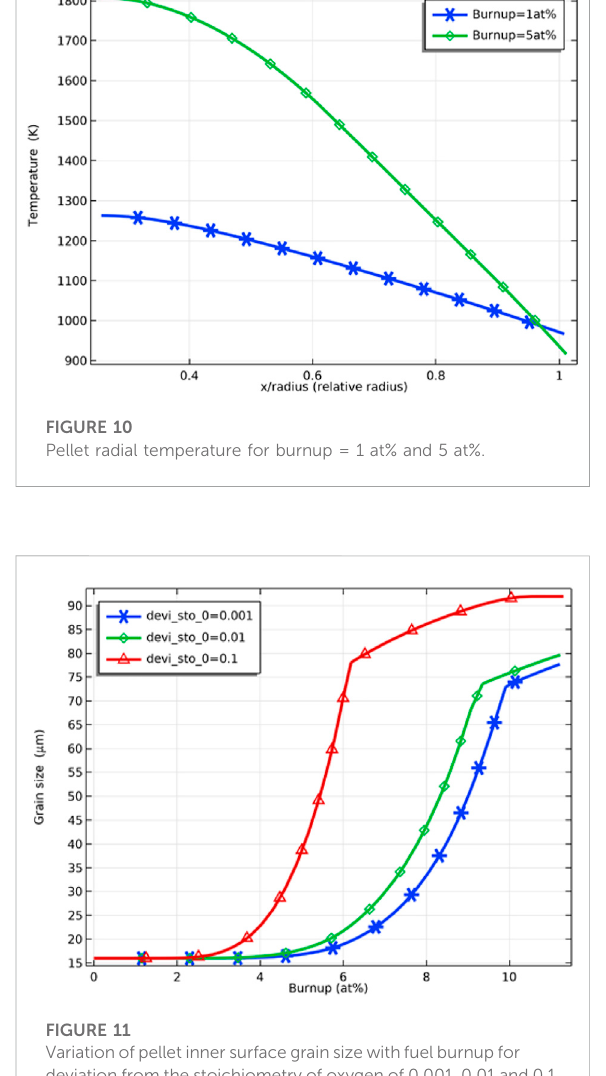
FIGURE 13 Variation of pellet inner surface porosity for deviation from the stoichiometry of oxygens of 0.001, 0.01 and